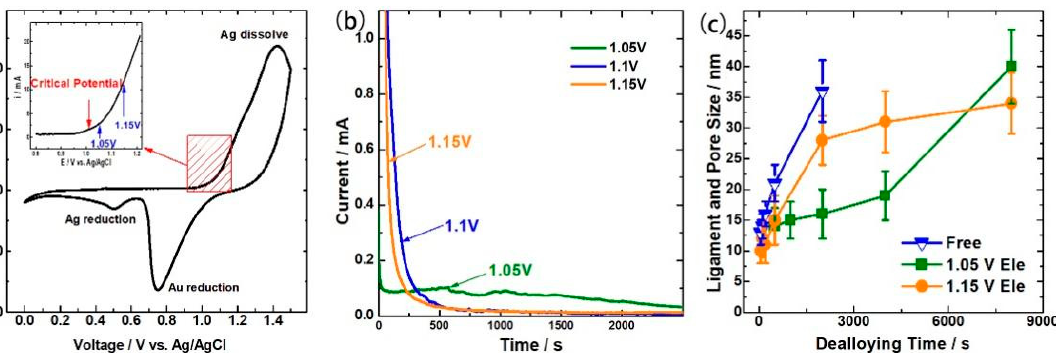
Figure 1. ( a ) Experimental cyclic voltammetry curve of Ag 65 Au 35 in 2 M HNO 3 acid solution (scan rate: 100 mVs − 1 ). ( b ) Typical dealloying curves of Ag 65 Au 35 in 2 M HNO 3 at different potentials with the same mass and geometrical area. Insets are the enlarged curves of the selective region. ( c ) Dealloying time dependences of ligament and pore size.